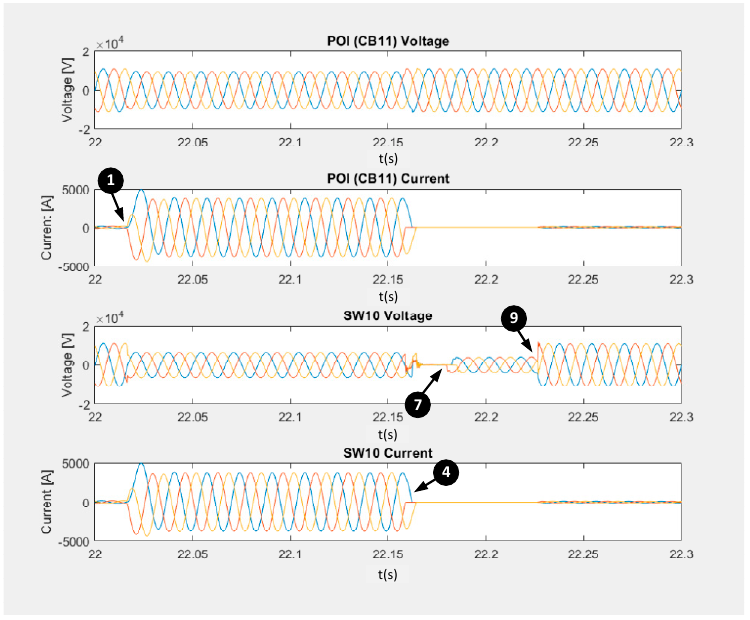
Figure 8. Fast fault detection, isolation, and restoration (F-FDIR) process for a fault between SW9 and SW10.